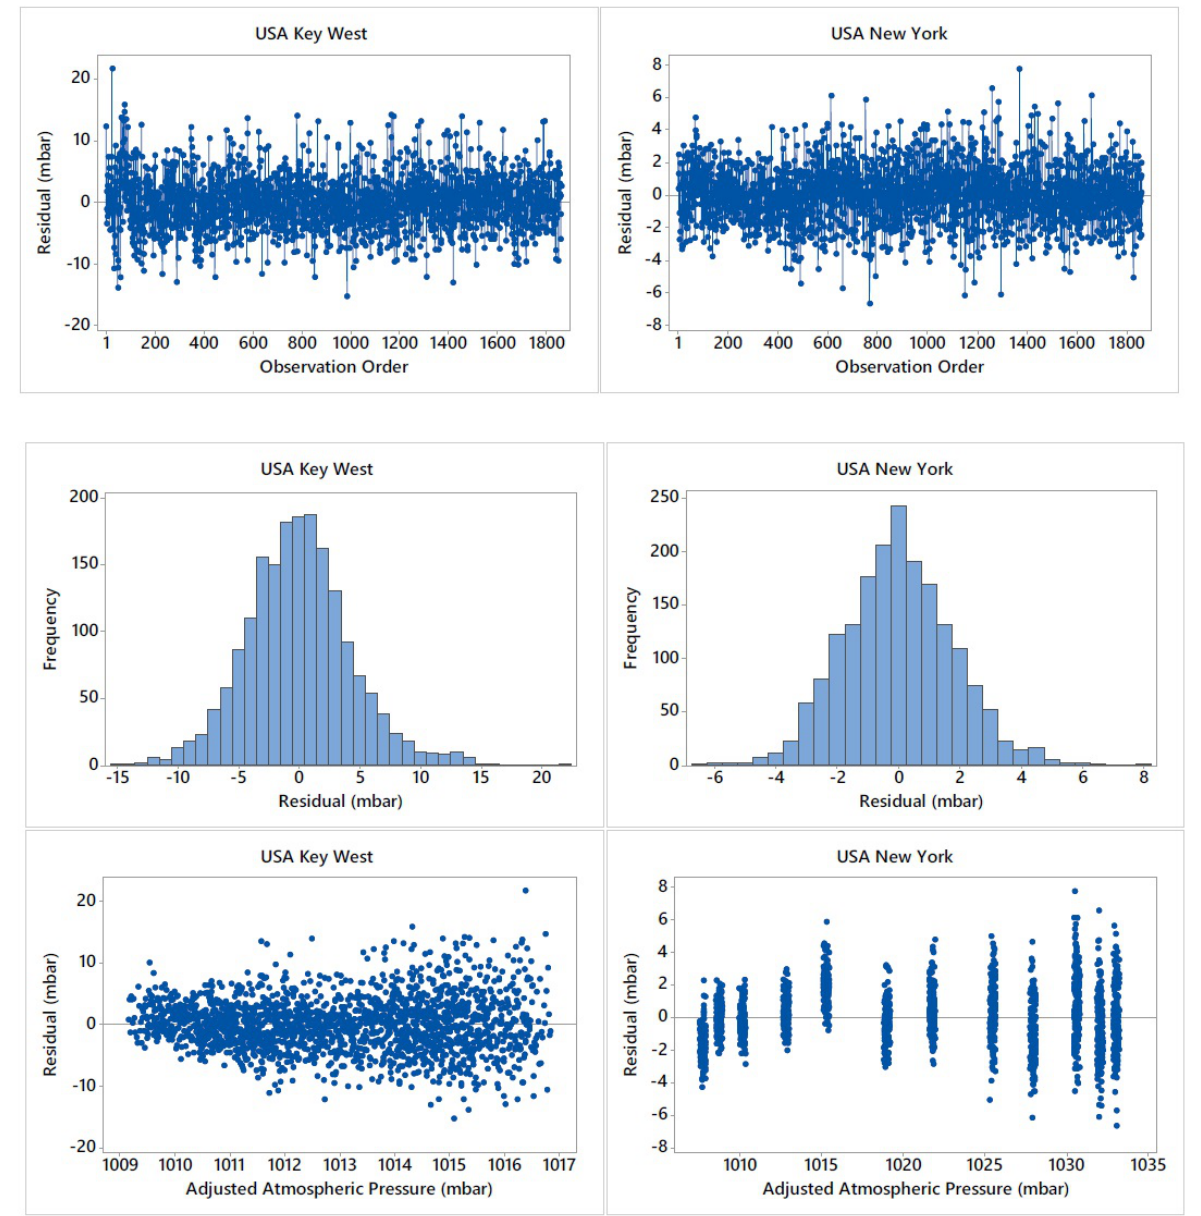
Figure 4: Residual atmospheric pressure plots at Key West and New York tide gauge stations in mb followed by their histograms. Third row plots are the residuals plotted agains their adjusted values (fitted